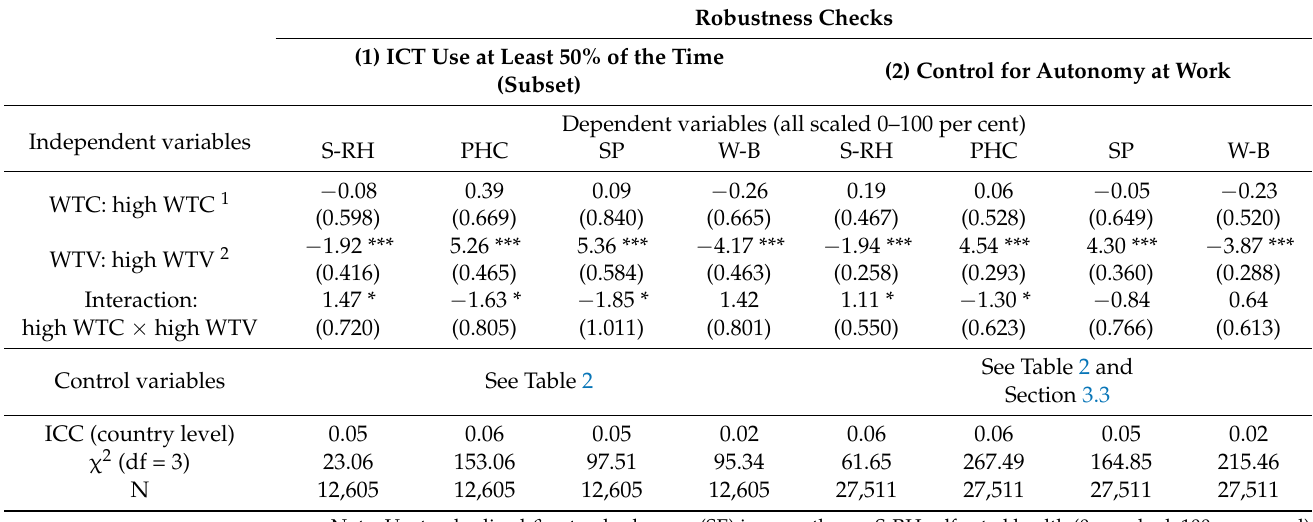
Table A2. Results of robustness checks, part I (ICT use, autonomy at work). Robustness Checks